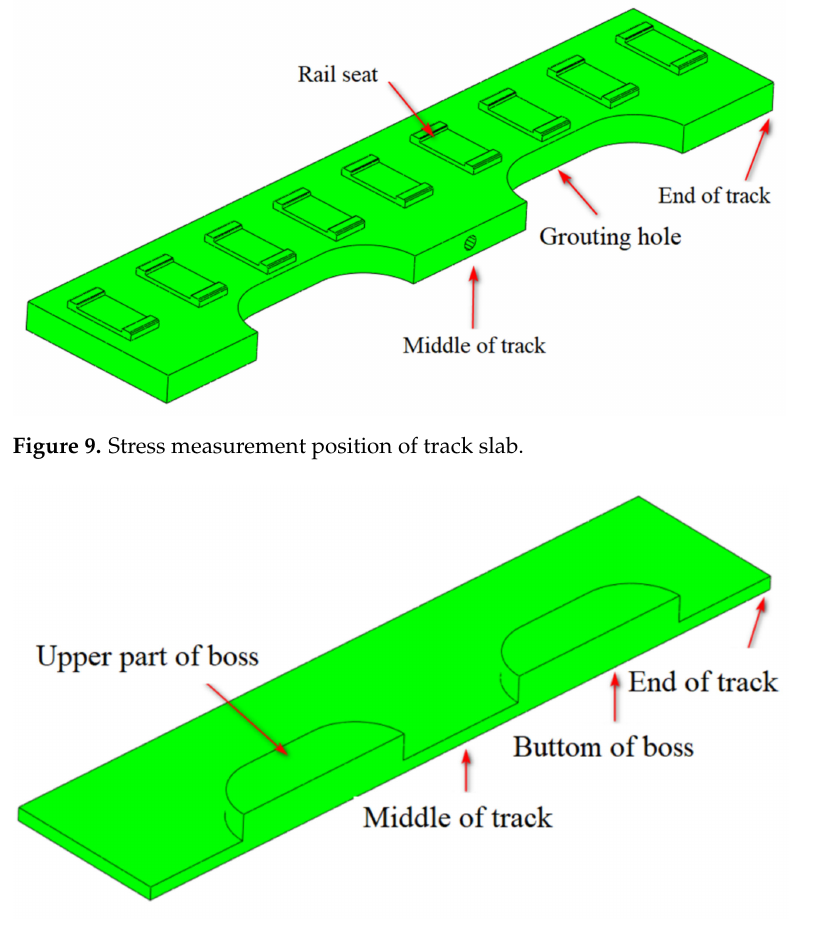
Figure 10. Stress measurement position of adjustment